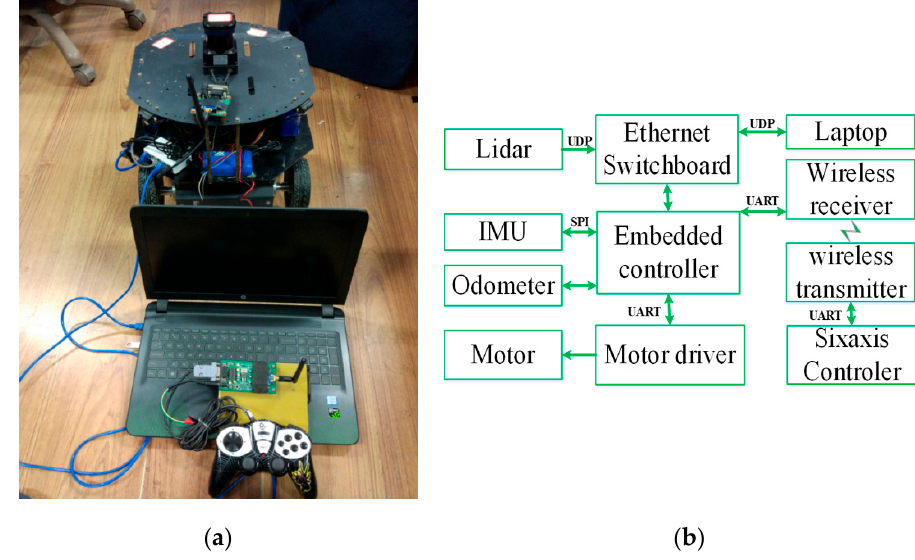
Figure 5. The mobile robot used for the experiment and its architecture. ( a ) The mobile robot used for the experiments; ( b ) The architecture of the mobile robot.